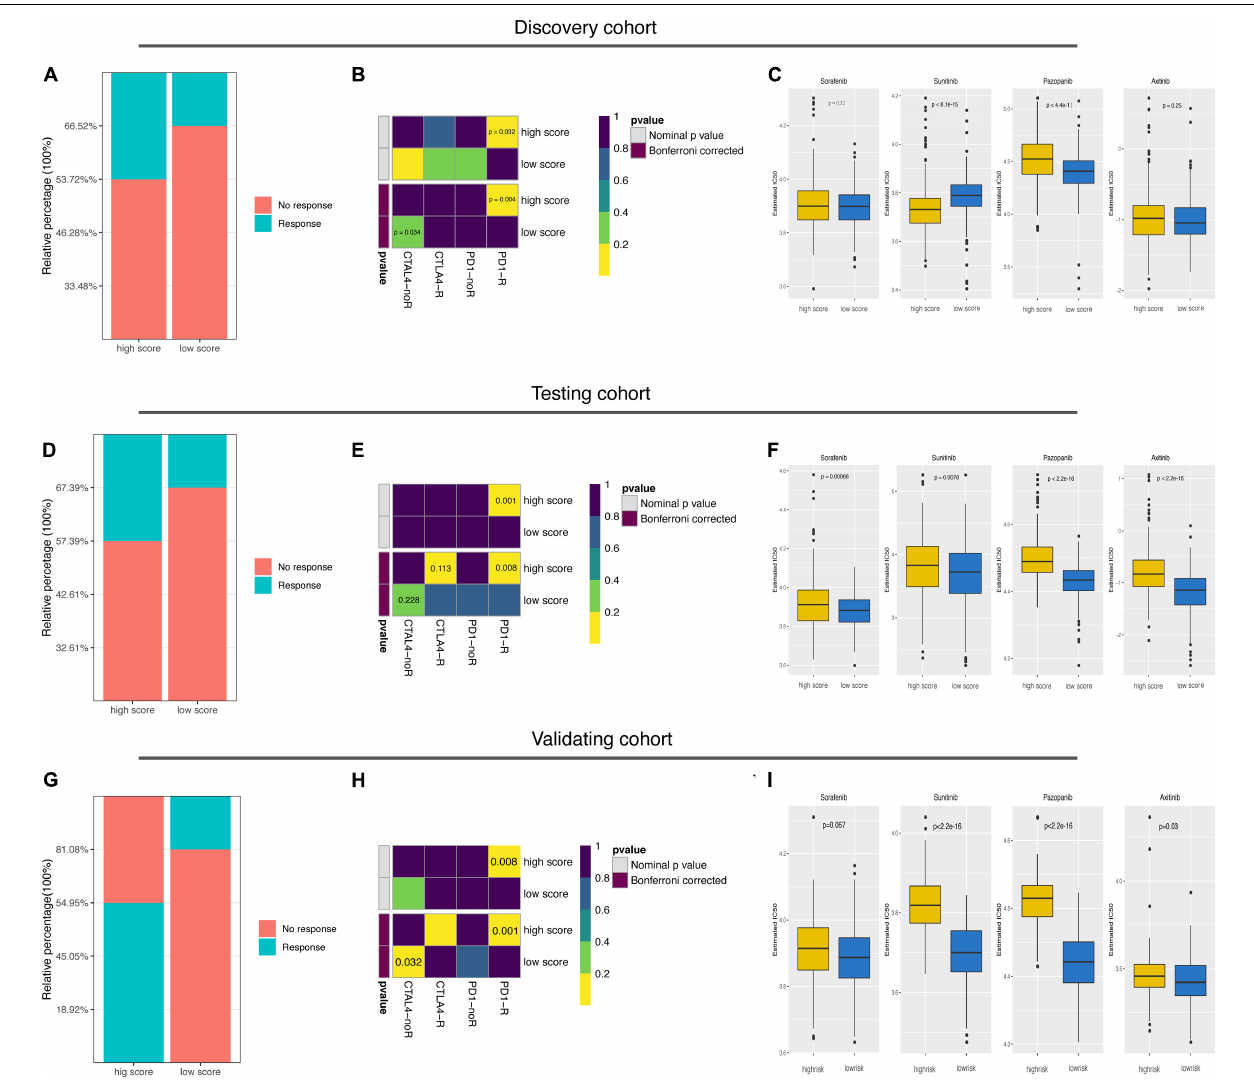
FIGURE 6 | Predictive value of ubiquitin score for immunotherapy and targeted therapies. (A,D,G) The predicted response rate in TIDE analysis of the discovery, testing, and external validating datasets. Fisher exact test, p = 0.003, p = 0.034, p = 3.71e-08, respectively. (B,E,H) Subclass mapping results indicated that the high score group was more likely to respond to anti-PD-1 treatment (Bonferroni corrected p -value = 0.004, 0.008, 0.001, respectively). (C,F,I) Boxplots of the estimated IC50 values for Sorafenib, Sunitinib, Pazopanib, and Axitinib in the three cohorts, Wilcoxon